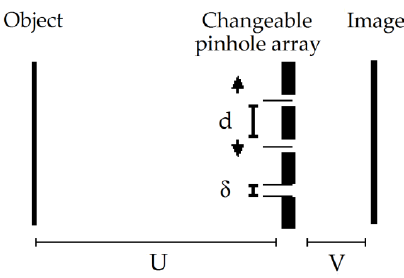
Figure 1. A schematic sketch of the proposed setup.